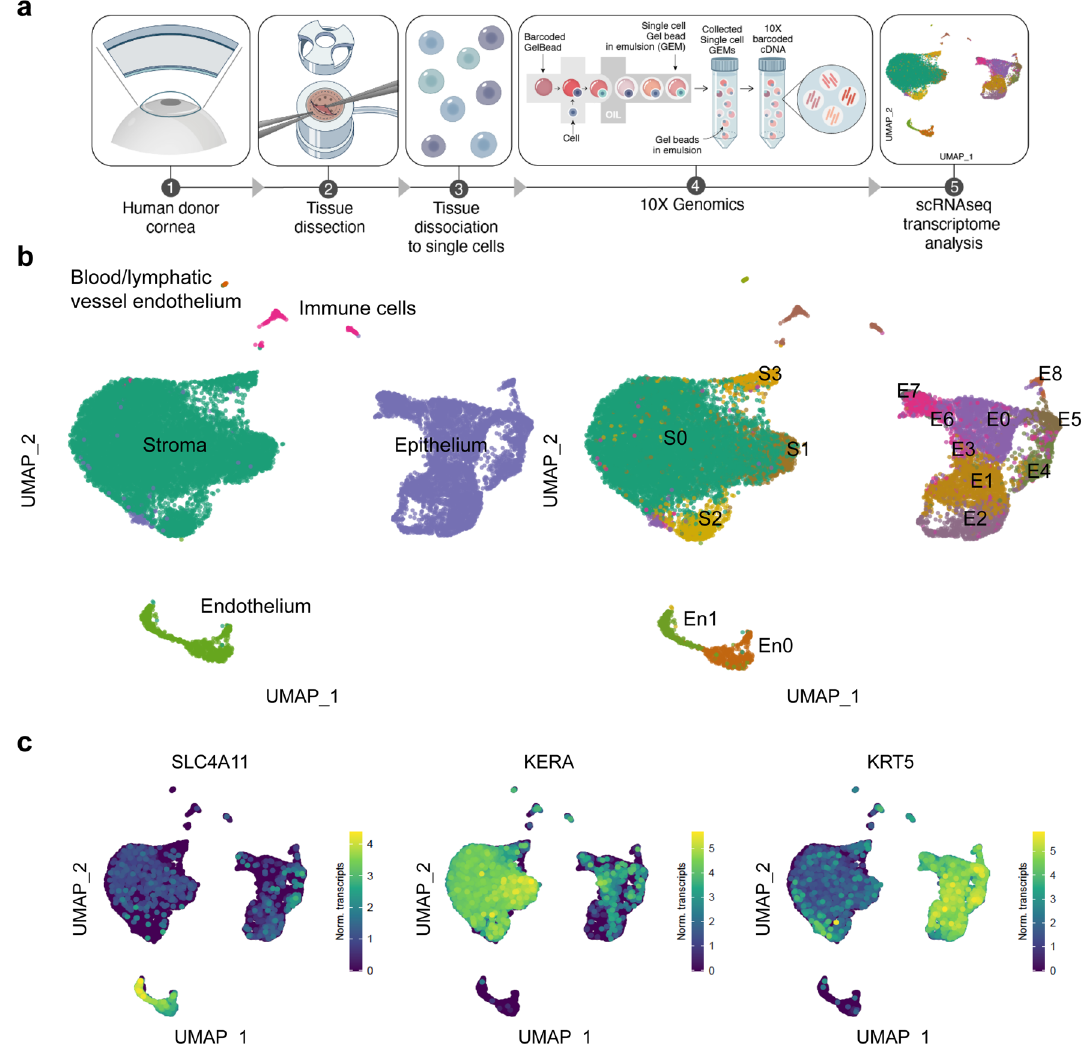
Figure 1. Cell clusters from all three corneal layers and two additional clusters of immune and blood/lymphatic endothelial cells were identified with scRNAseq analysis. Experimental overview for scRNAseq ( a ). UMAP of the 19,472 sequenced cells with the identified five major cell clusters ( b , left). Cell clusters from the three corneal cell layers were further subclustered in different cell subpopulations ( b , right). Single cell expression level UMAP of specific corneal layer markers supports cell cluster identification ( c ): SLC4A11 is corneal endothelial–specific, KERA is corneal stromal–specific, and KRT5 is corneal